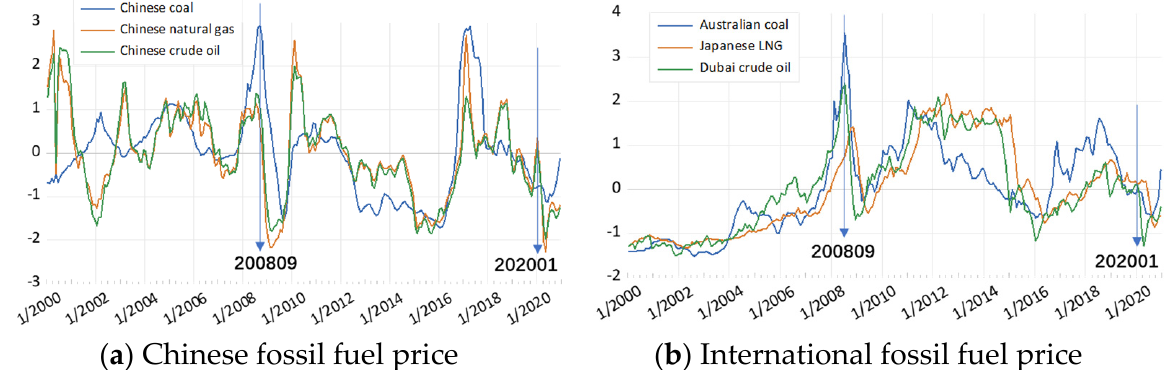
Figure 1. Plots of the Chinese and international fossil fuel prices.